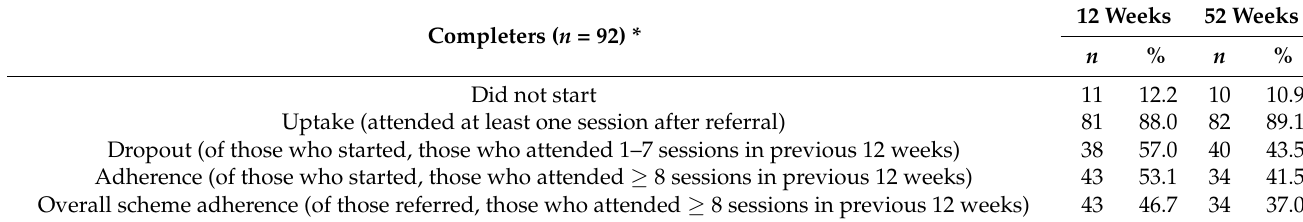
Table 5. Study completers: adherence at 12 and 52